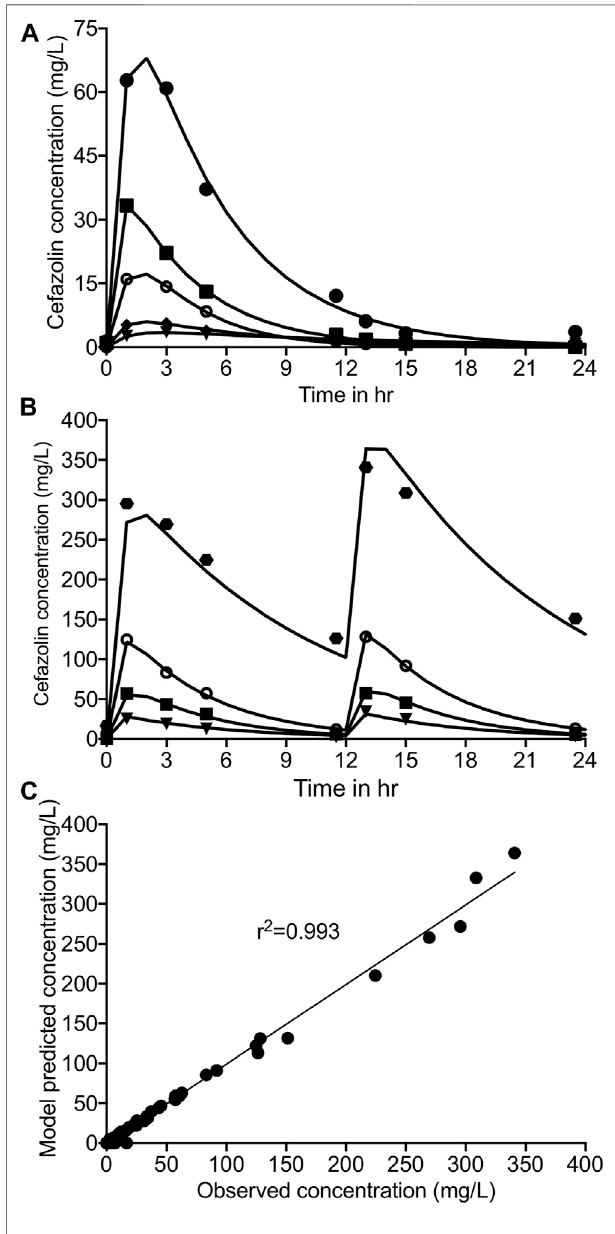
FIGURE2| Cefazolinconcentration-timepro fi leintheHFS-TB.Symbols show the drug concentration measured in the HFS-TB, whereas solid line represent the model predicted concentrations. Cefazolin concentration time pro fi le (A) with oncedailydosing, (B) with twice-daily dosing schedule of cefazolin in the HFS-TB. (C) Model fi t to show minimal bias between the cefazolin concentration measured in the HFS-TB vs the pharmacokinetics model predicted